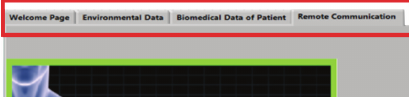
Figure 15: Interface created in LabVIEW for remote communica- tion [14].